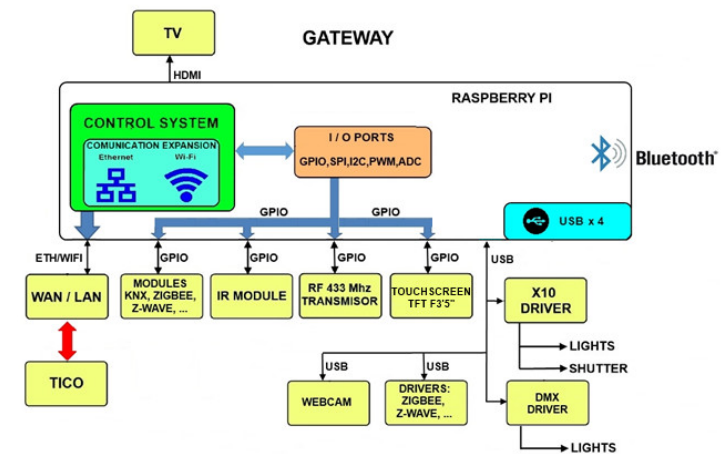
Figure 11. Platform and home control communication elements.